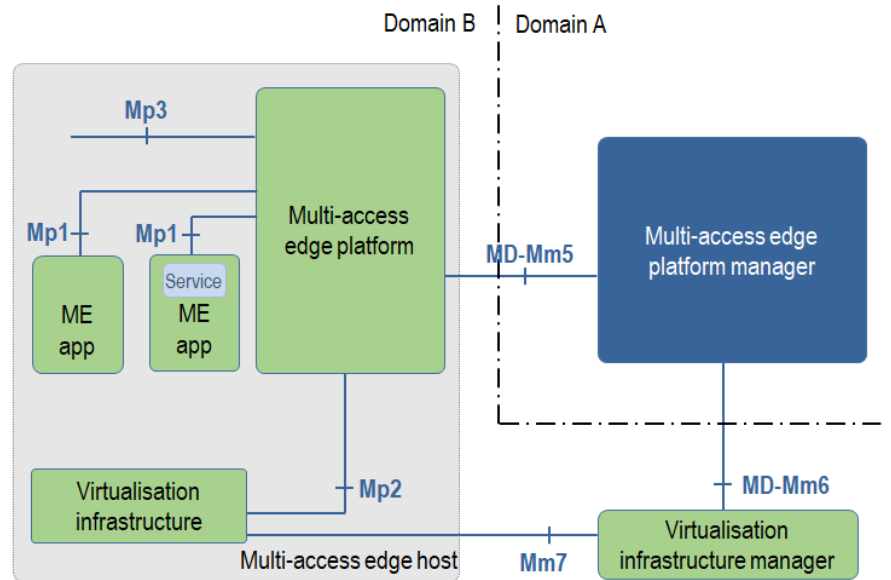
Figure 4. Integration of MEC providers at platform level following a PaaS approach with infrastructure owned by Domain B provider.